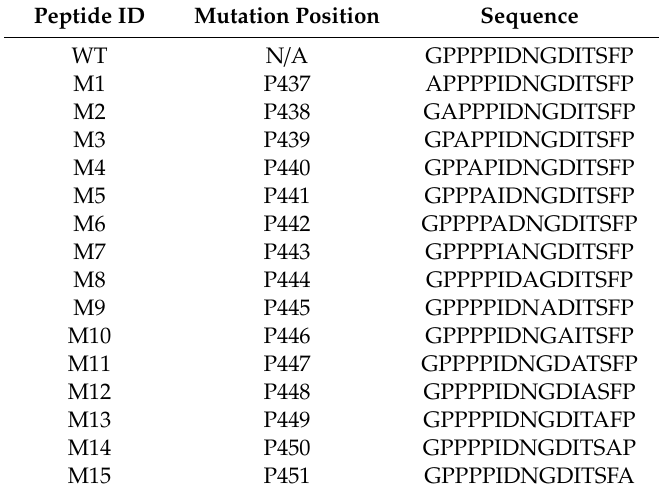
Table 3. Amino acid sequence of complement factor H (CFH) wild-type and mutant peptides. Peptide